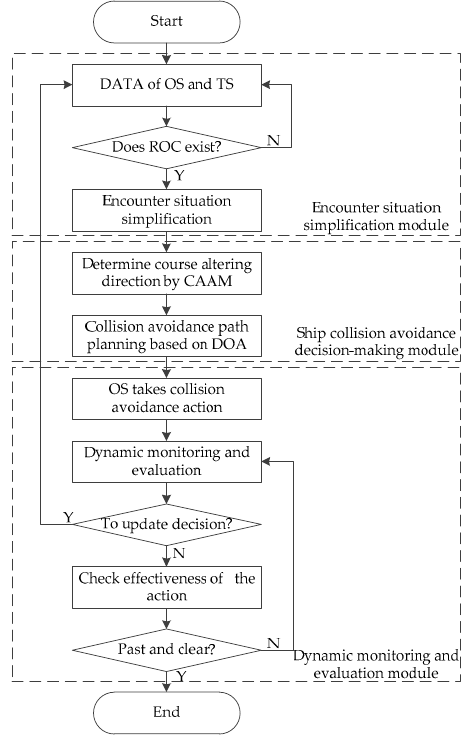
Figure 5. Model of collision avoidance